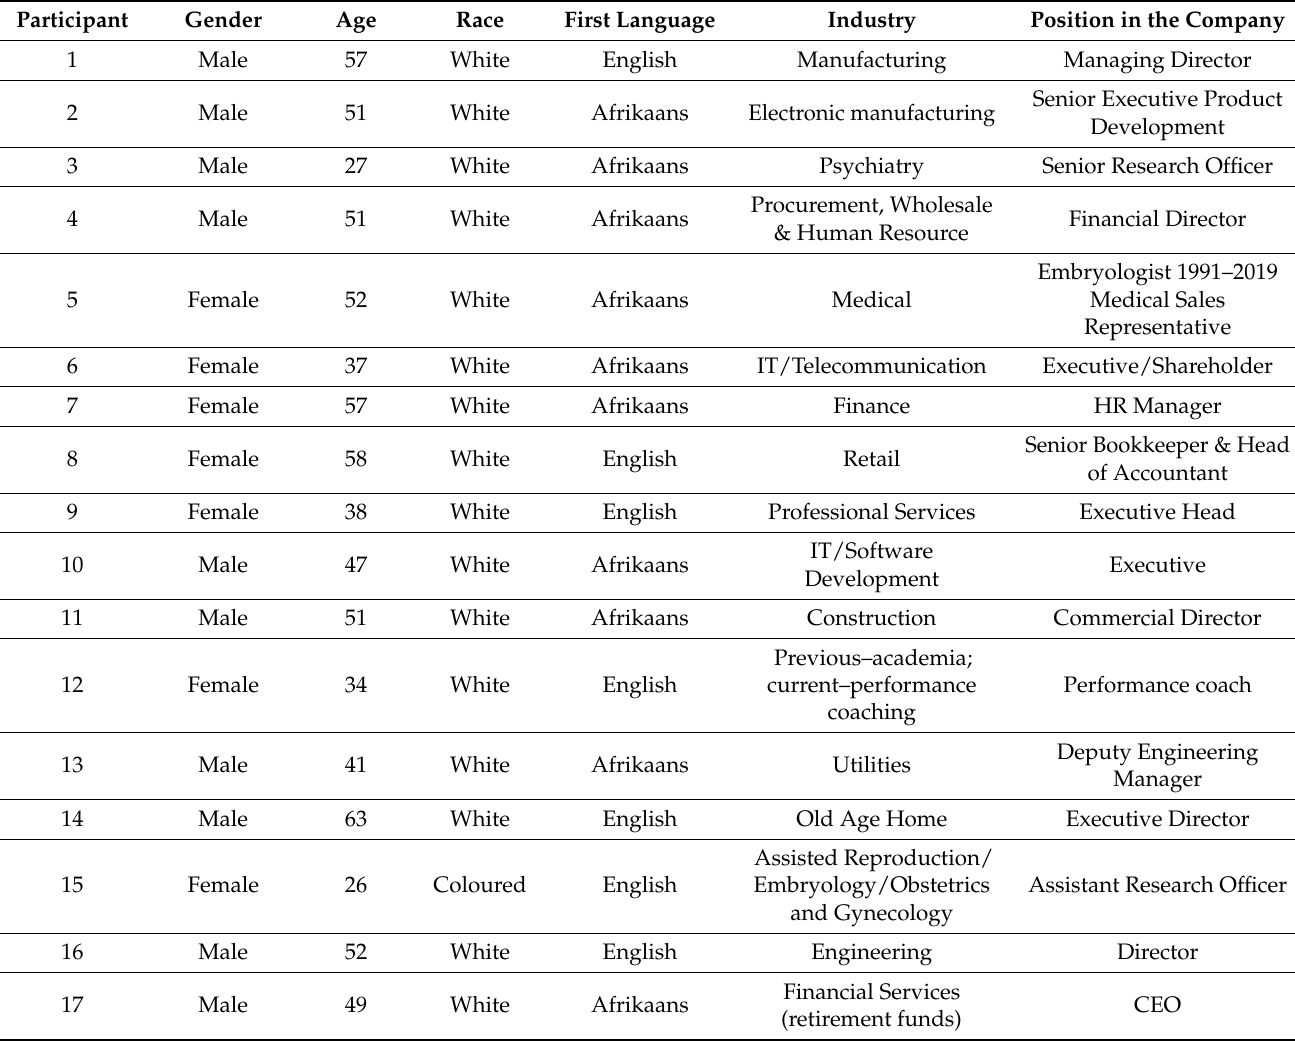
Table 2. Biographical Information of